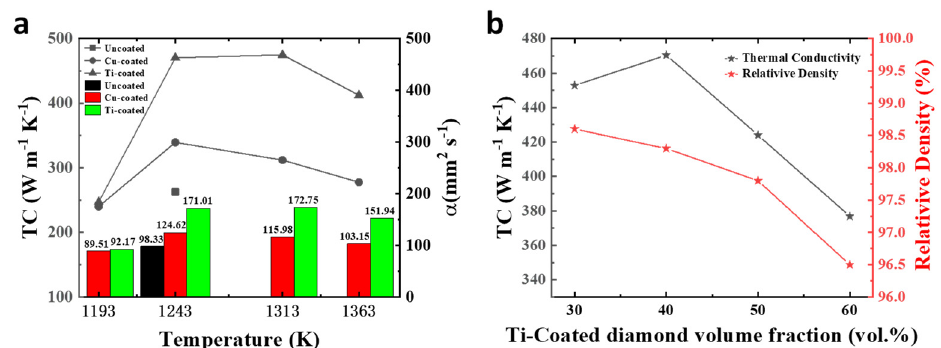
Figure 5. ( a ) Thermal conductivity (TC) and thermal diffusivity of 40 vol.% uncoated diamond/Cu, Cu-coated diamond/Cu, Ti-coated diamond/Cu composites under different temperatures; ( b ) TC and relative density for 30–60 vol.% Ti-coated diamond/Cu composites fabricated at the same temperature of 1243 K.